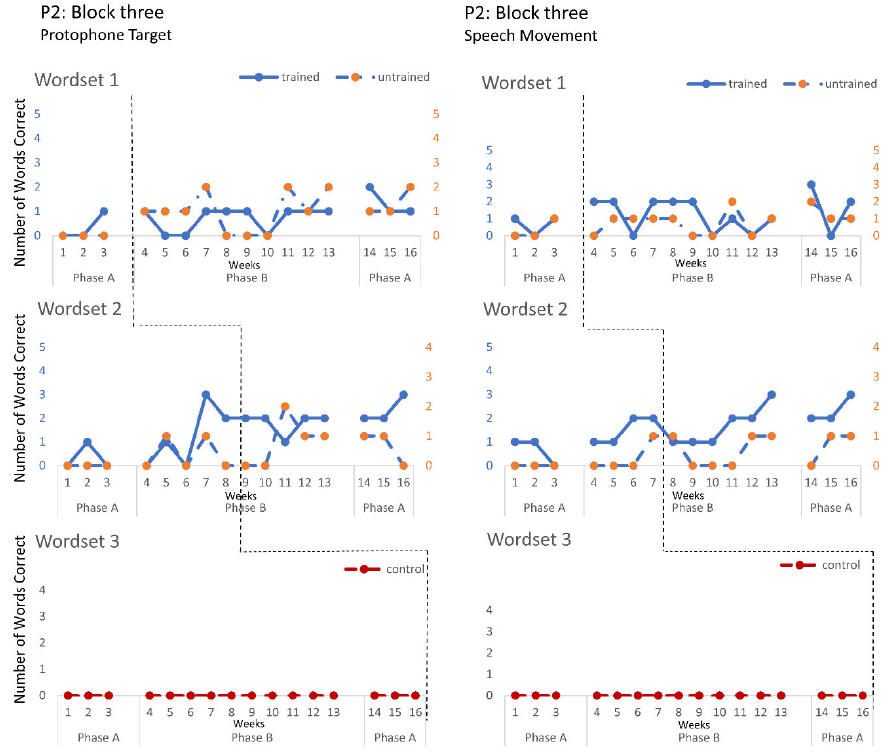
Figure 7. Accuracy of performance on the speech probes as scored for protophone target ( left ) and motor ‐ speech movements ( right ) block three, participant 2. P3 . P3 participated in two intervention blocks. During block one, there was a moder ‐ ate increase in the production of controlled phonation on single protophones in word set 1, with no controlled phonation evident during baseline. Jaw transitions from closed ‐ to ‐ open and closed ‐ to ‐ open were not produced with communicative intent. These treatment effects were not maintained during post ‐ intervention baseline. In contrast to block one, block two reveals a very large and significant treatment effect on trained word sets 1 and 2, for both protophone and speech movement targets, and large significant effects on word sets 1 and 2 untrained items for speech movement target for CV, VC and CVC words containing bi ‐ labials (/b/, /p/, /m) , alveolars (t/d/ and the velar (/g/). Post intervention data show the treatment effects were maintained for word sets 1 and 2.